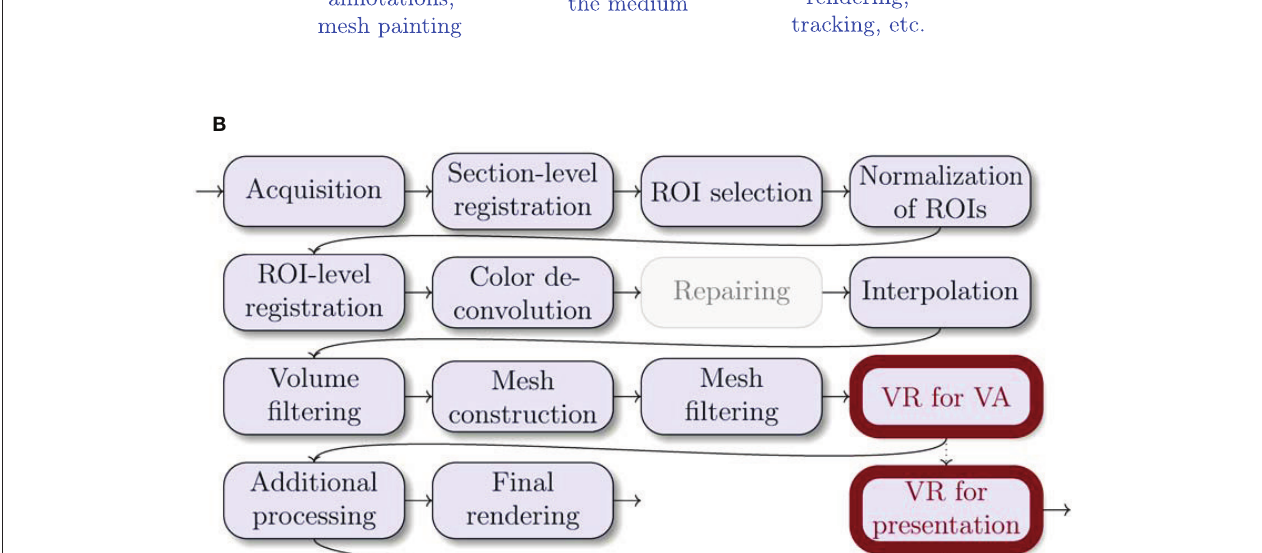
thick sections in transmitted light. Hence, the